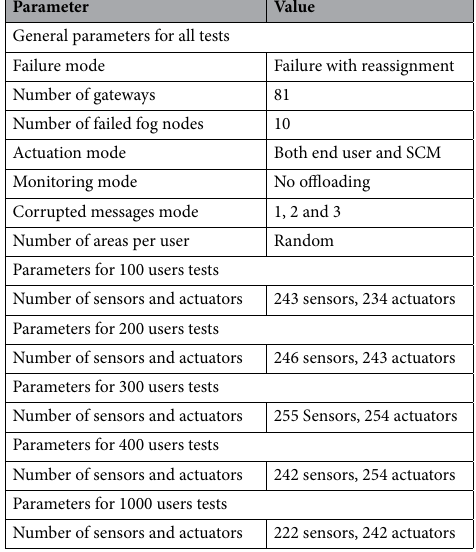
Table 7. Configuration parameters for observation filtring modes.